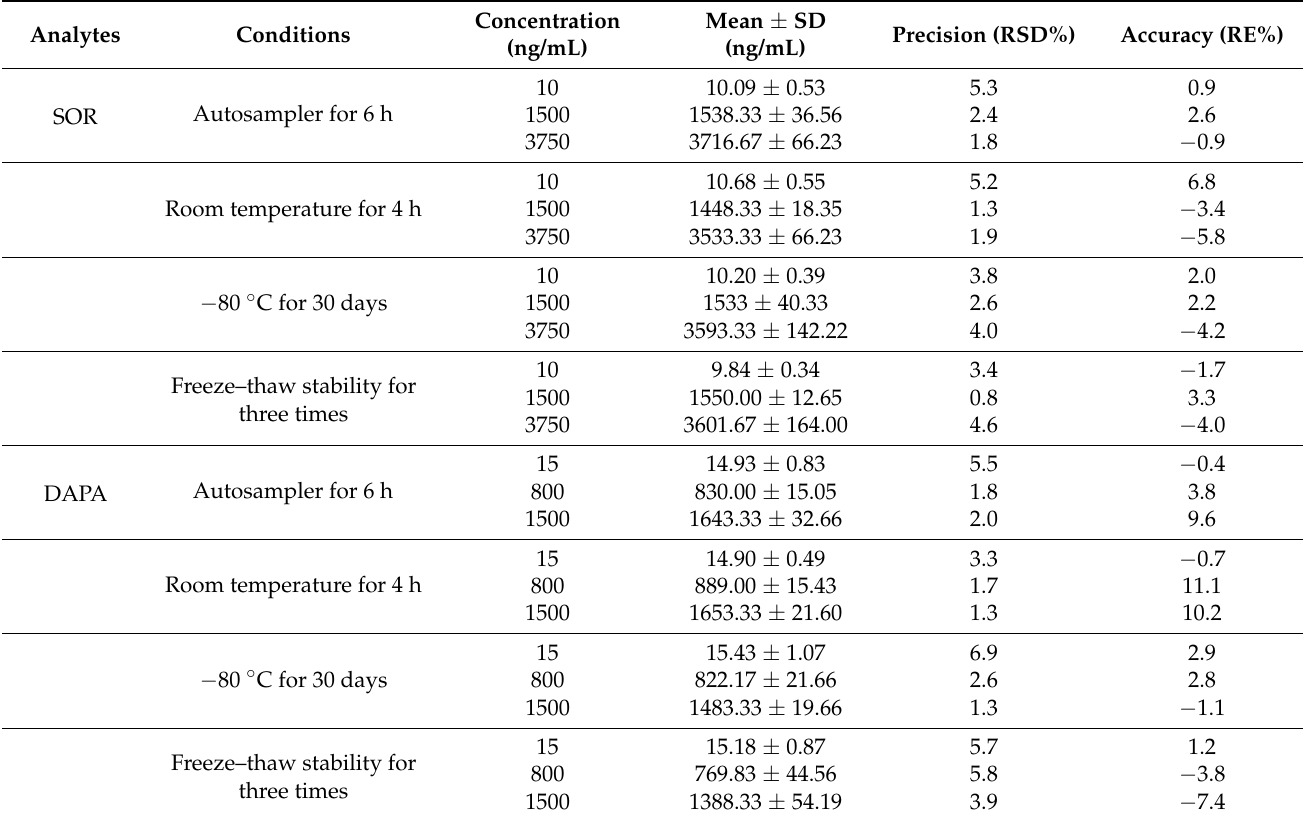
Table 3. Stability of SOR and DAPA in rat plasma under different conditions ( n =